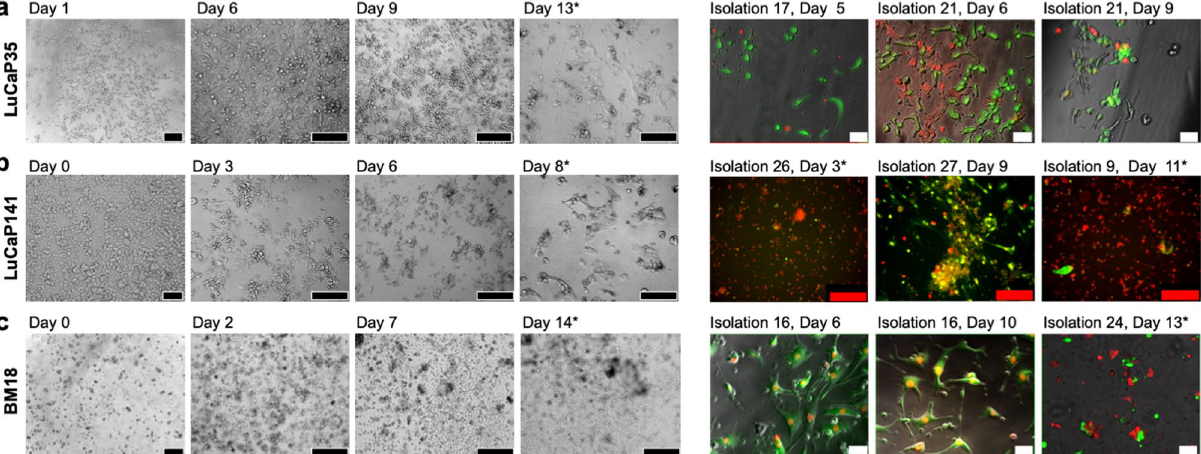
Figure 3. Mouse cell-depleted PDX PCA cells in monolayer culture in HCM. ( a ) LuCaP35, ( b ) LuCaP141, and ( c ) BM18. Representative viability staining is shown from different PCa cell isolations and timepoints. Live cells are green (Calcein AM), and dead cells are red (Ethidium Homodimer-1). Black and white scale bars = 50 µm, red scale bars = 200 µm. Asterisks indicate the timepoint where cultures were terminated and stained because of poor viability.